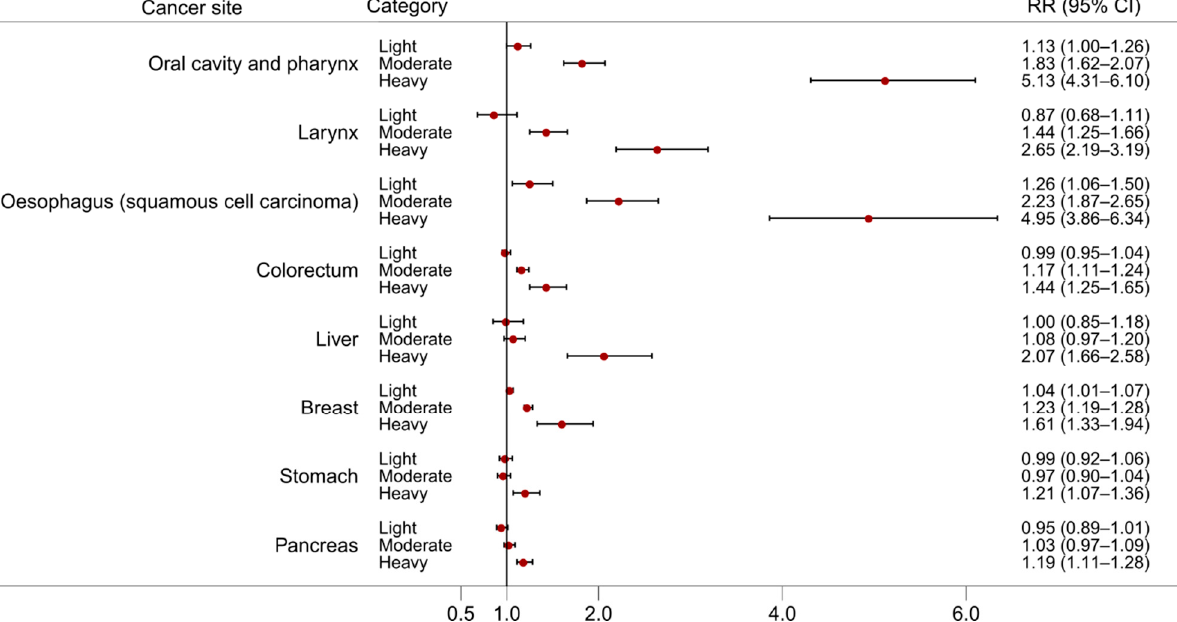
Figure 3. The dose-response relationship for the risk of cancer at different sites by three level of alcohol intake: light (up to 12.5 g/day), moderate (12.5 to 50 g/day), and heavy (more than 50 g/day). Source of relative risk estimates: Bagnardi and colleagues [8]. RR = Relative risk; CI = Confidence interval.